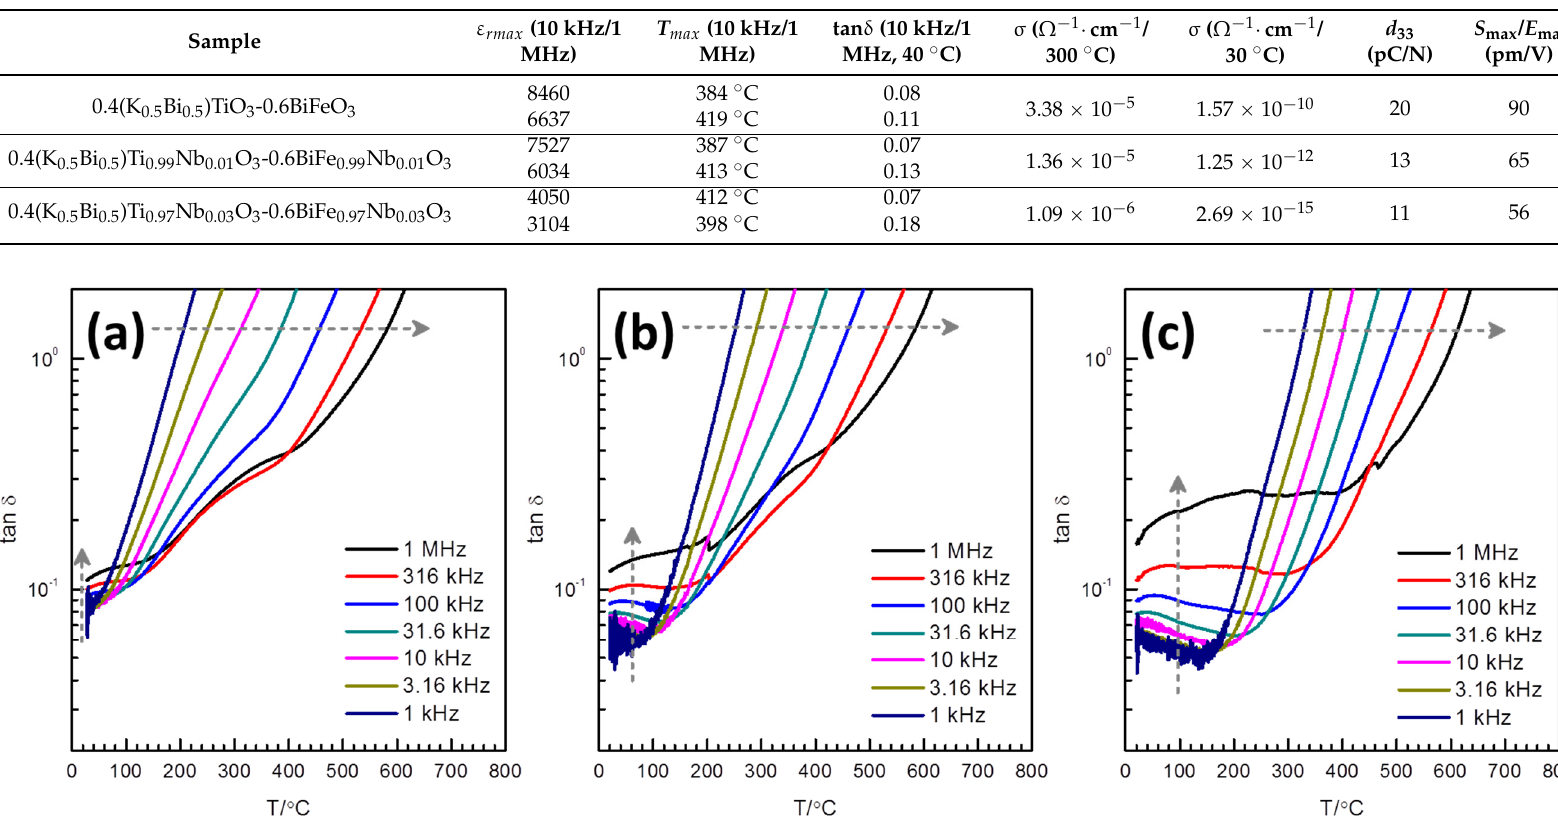
˝ C for 1 h: ( a ) x = 0.00; ( b ) x = 0.01; and ( c ) x =